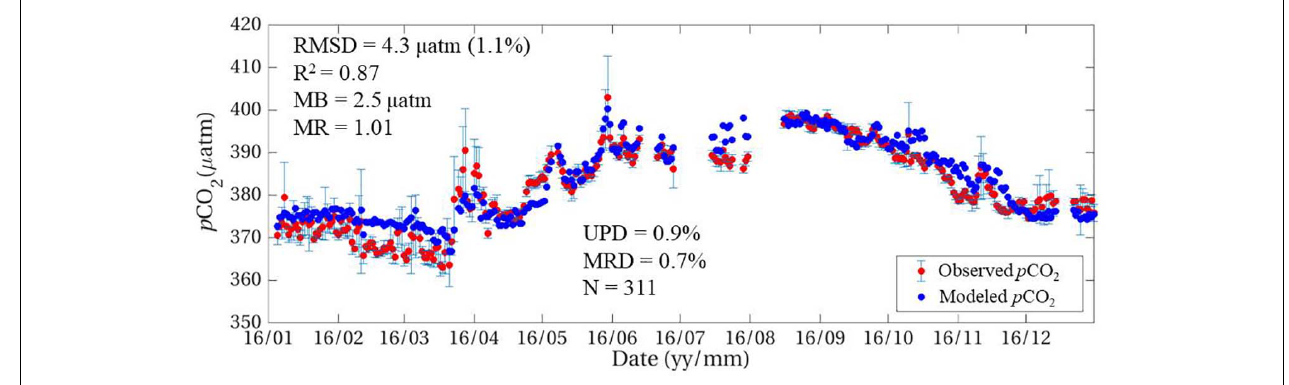
FIGURE 4 | The RFRE model performance in reconstructing the surface p CO 2 sw data time series in 2016, in comparison with the corresponding mooring-observed surface p CO 2 sw. Note that none of the field observations in 2016 was used in the model development. The error bar represents one standard deviation of the diurnal changes of p CO 2 sw time series.